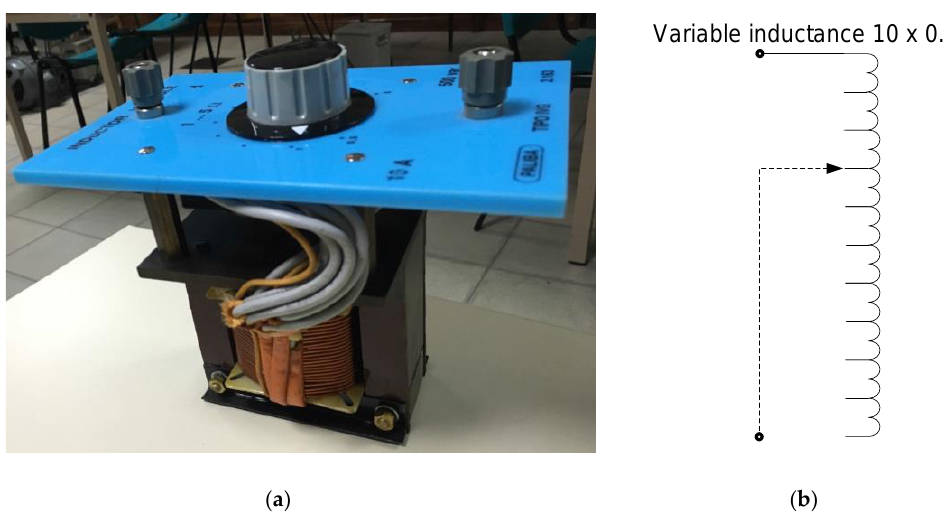
Figure 14. Variable inductance ( L1 , L2 ) used to simulate faults at any point of any subsection; ( a ) Picture; ( b ) Electrical diagram.